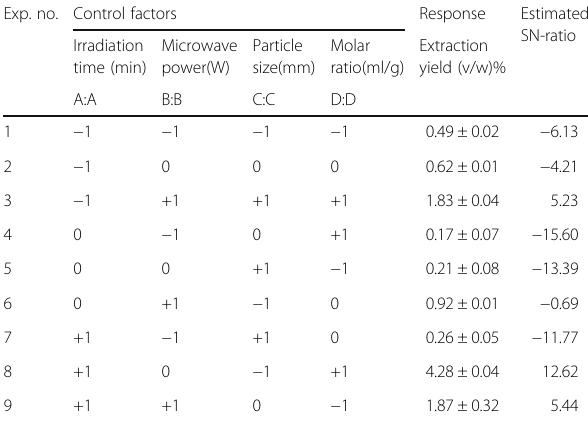
Table 4 GC-MS analysis of various components inside the